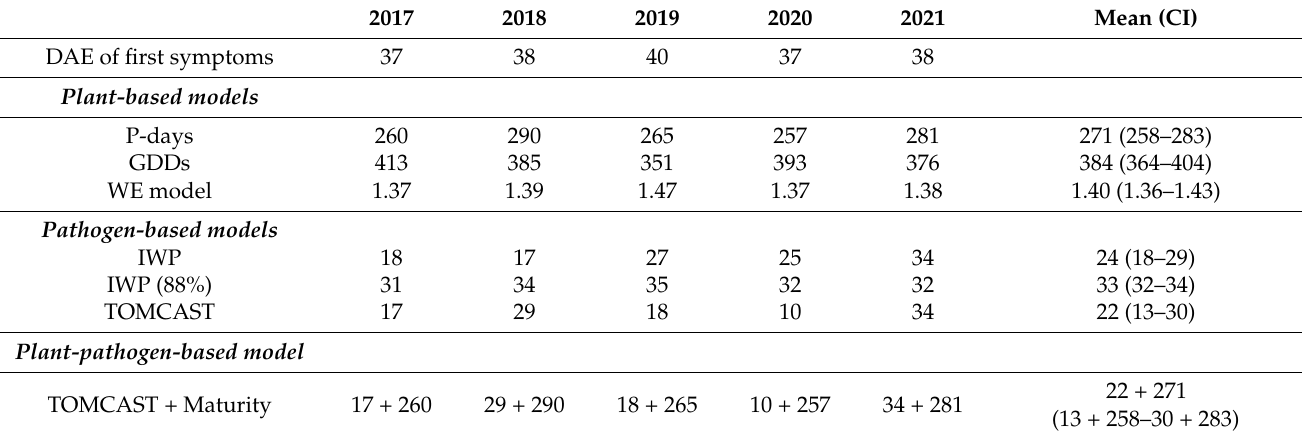
Table 4. Adjustment of the original models of early blight in A Limia according to weather conditions and first observations of the disease in the